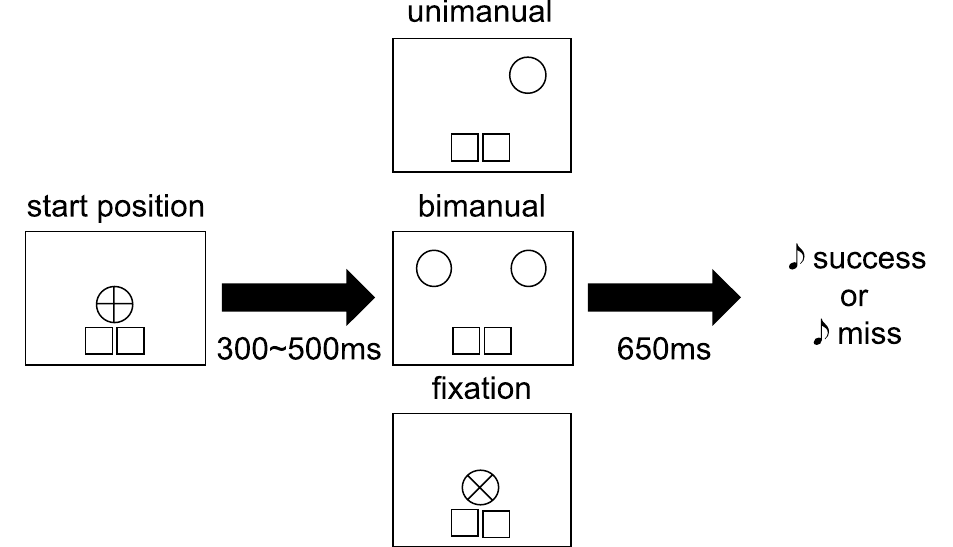
Figure 3. Task protocol. At the start of each trial, the participants were instructed to press the pressure sensors and focus their eyes on the fixation point. Three types of trials were thereafter presented randomly. In “unimanual reach trials”, the participants reached with one hand toward the target. In “bimanual reach trials”, two target circles were presented and the participant simultaneously reached out to them with both hands. In “fixation catch trials”, the “+” at the centre of the fixation circle changed to “×” and the participants moved both hands to the fixation circle. When one of the sensors on the index finger entered the target circle within 650 ms, the target disappeared and a sound indicating success was played. Otherwise, the target did not disappear and a sound signalling failure was played.